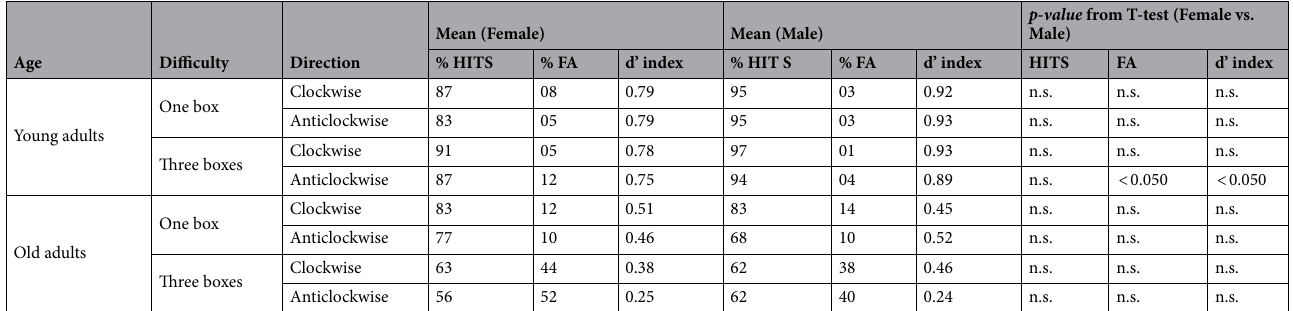
Table 2. Mean percentage of Hits, False Alarms (FA), and d’ score for each factor, Age (old and young), Sex (female, male), Difficulty (one box and three boxes) and Direction (clockwise and anticlockwise).